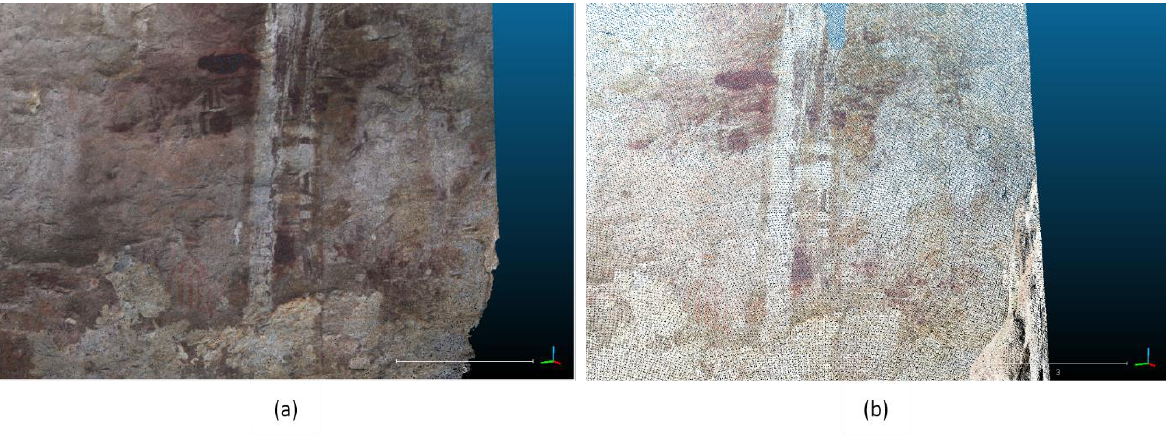
Figure 6: The visual comparison of color point cloud from (a) multispectral, and (b) terrestrial laser scanner.